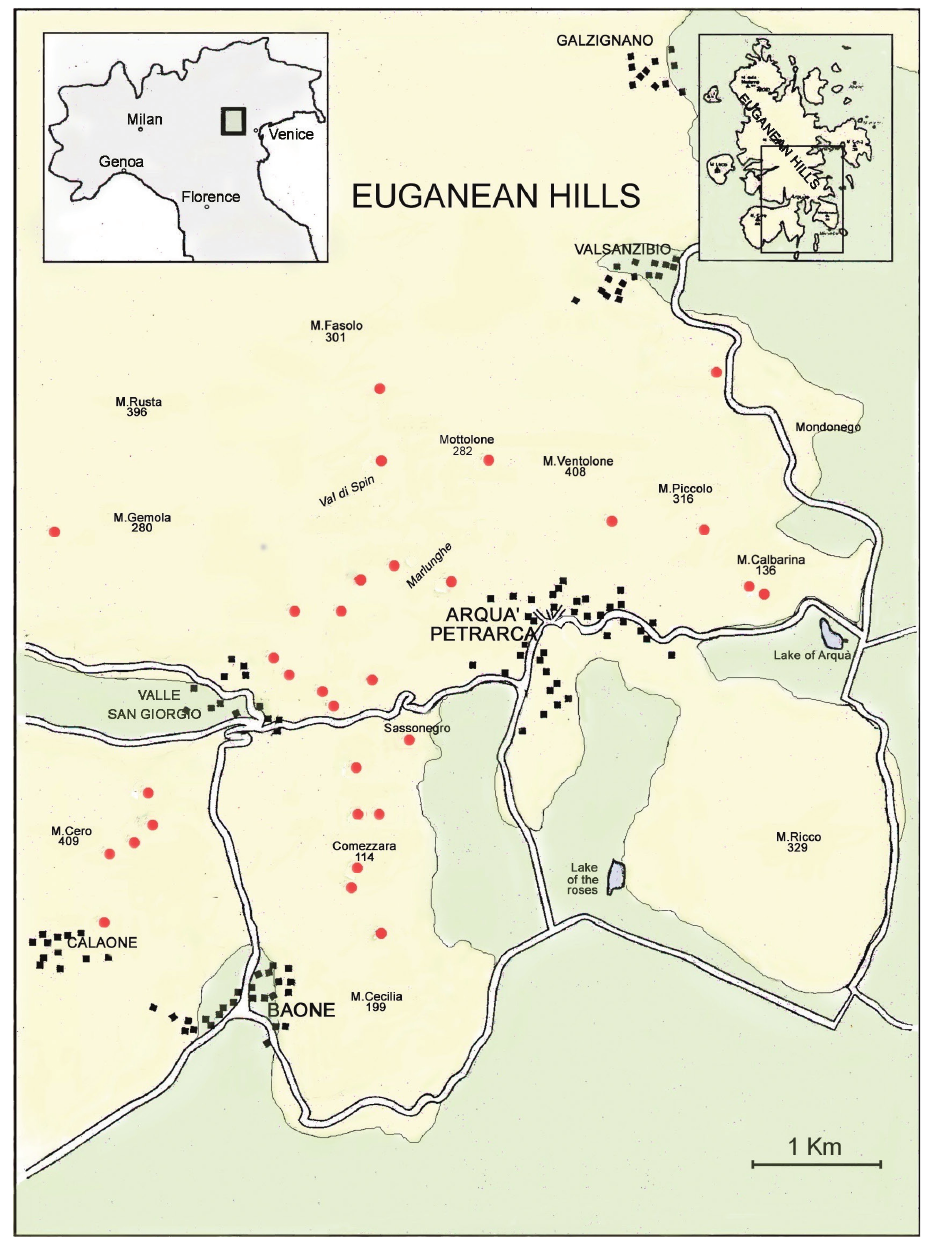
Figure 4. Distribution (red dots) of Haplophyllum patavinum (L.) G.Don in the Euganean Hills (Padua) as resulting from the surveys carried out in the years